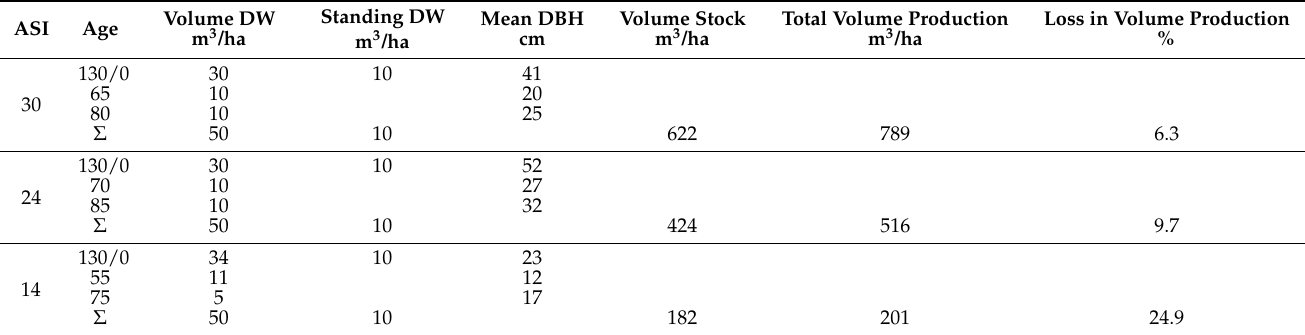
Table 5. Design of active deadwood (DW) management for